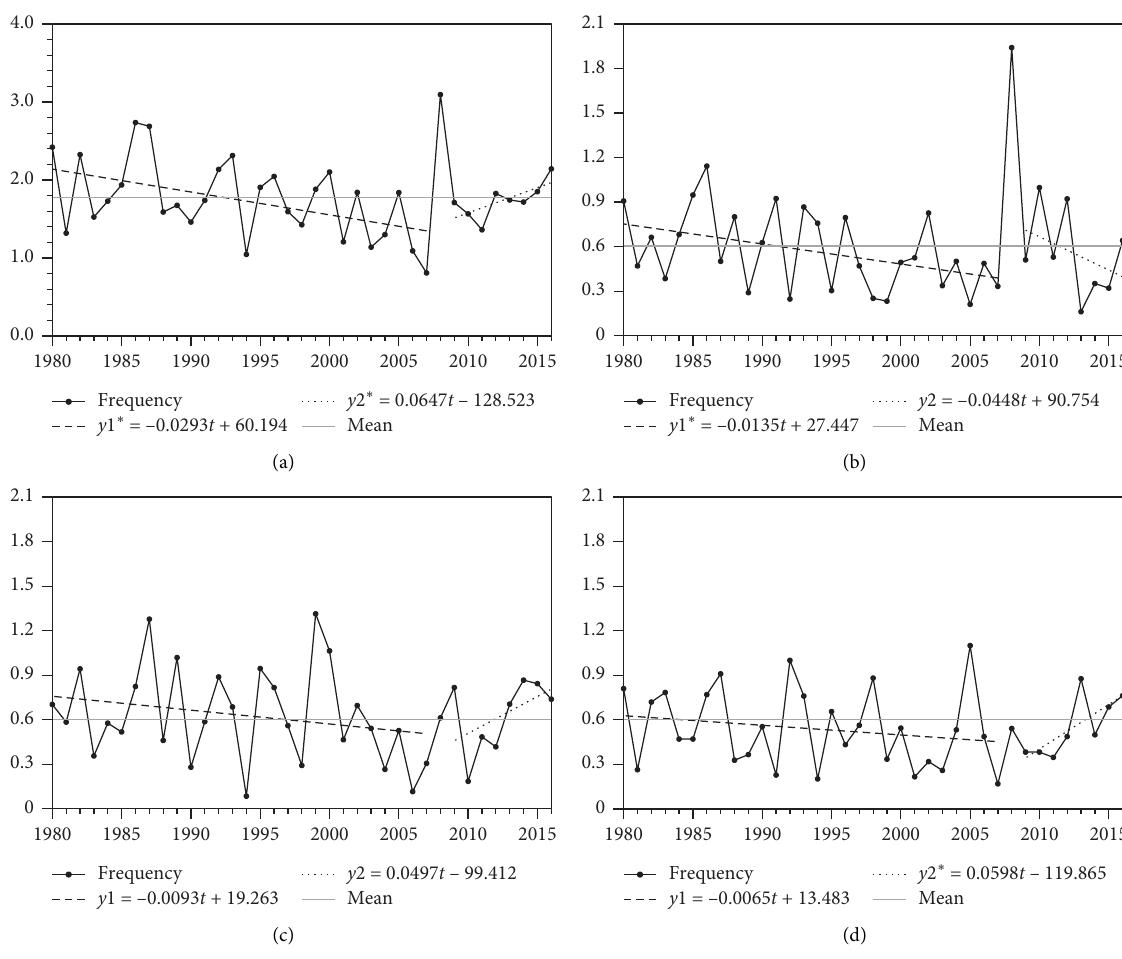
Figure 3: The regional average series of the SSECE frequency (solid line) and its linear trend (dotted line) in North China in winter (a), December (b), January (c), and February (d) from 1980 to 2016 (unit: number of occurrences). One asterisk ∗ represents significance at the 95% confidence level using Student’s t